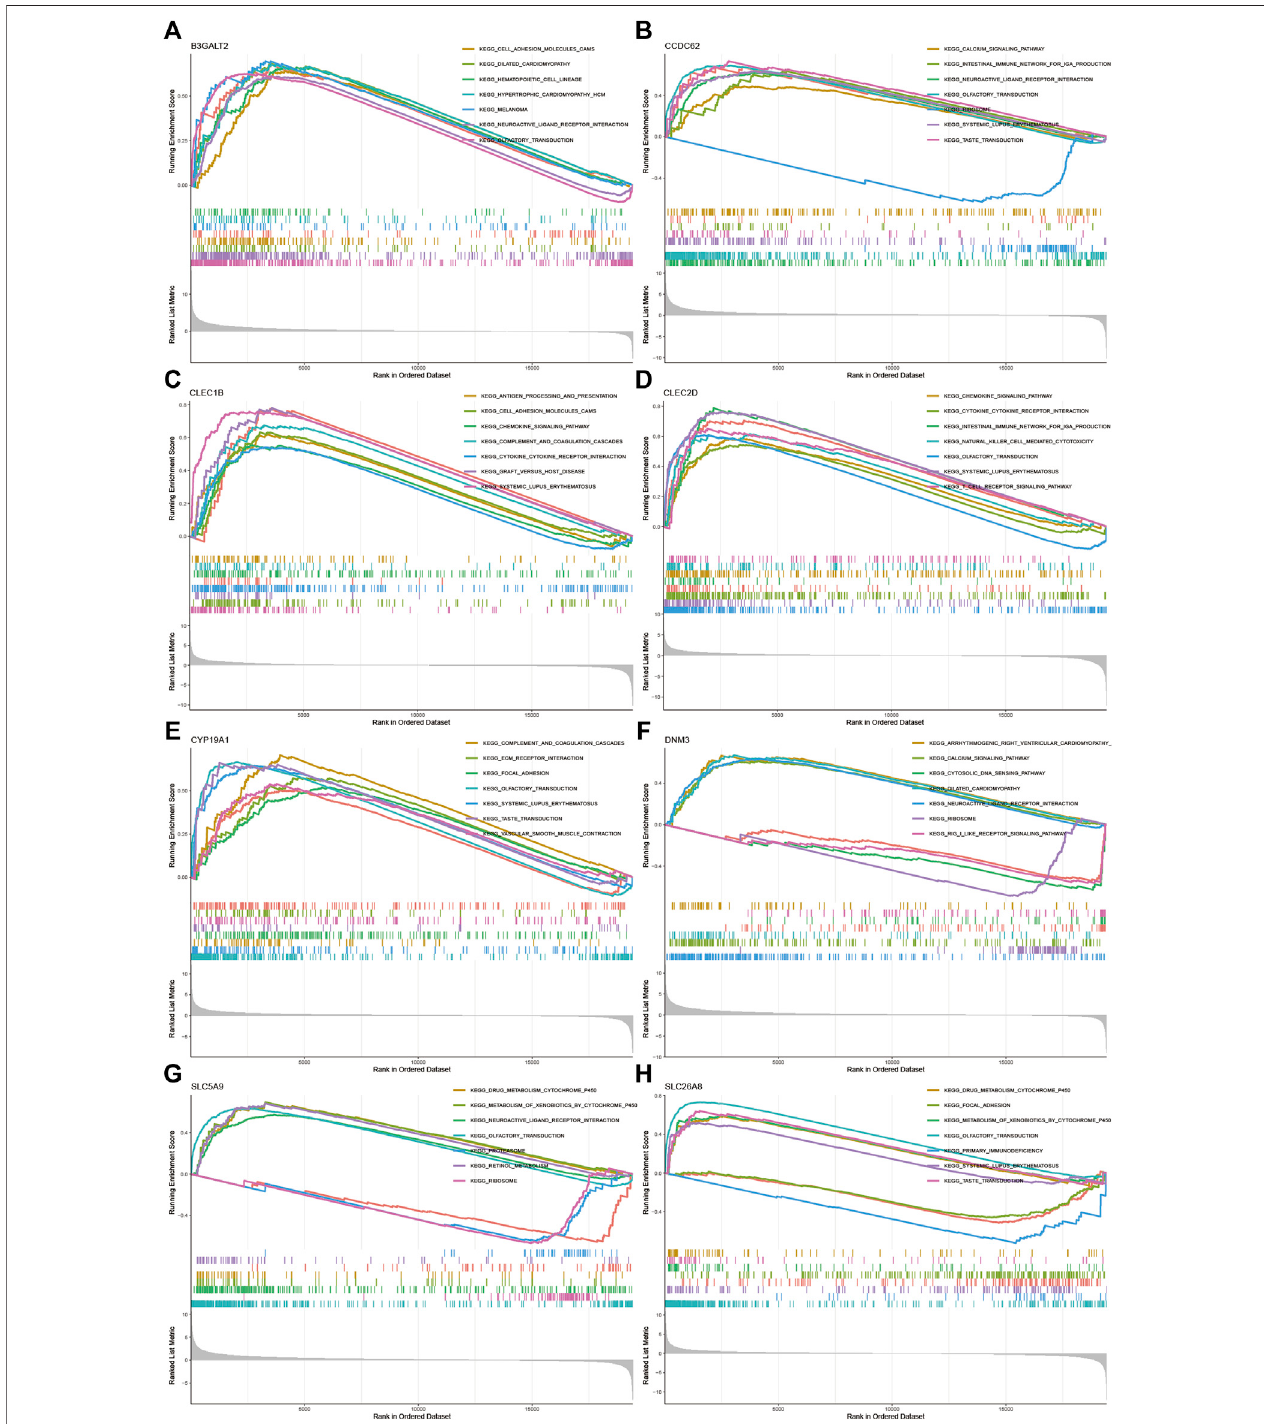
FIGURE5| GSEAforsampleswithhighandlowexpressionof9centralgenes (A) EnrichedgenesetcollectedinKEGGforsampleswithhigh B3GALT2 expression (B) Enriched genesetcollectedinKEGGforsampleswithhigh CCDC62 expression (C) Enriched geneset collectedinKEGGforsampleswithhigh CLEC1B expression (D) EnrichedgenesetcollectedinKEGGforsampleswithhigh CLEC2D expression (E) EnrichedgenesetcollectedinKEGGforsampleswithhigh CYP19A1 expression (F) High DNM3 expression sample enriched gene set collected in KEGG (G) Enriched gene set collected in KEGG for samples with high SLC5A9 expression (H) Enriched gene set in the KEGG collection for samples with high SLC26A8